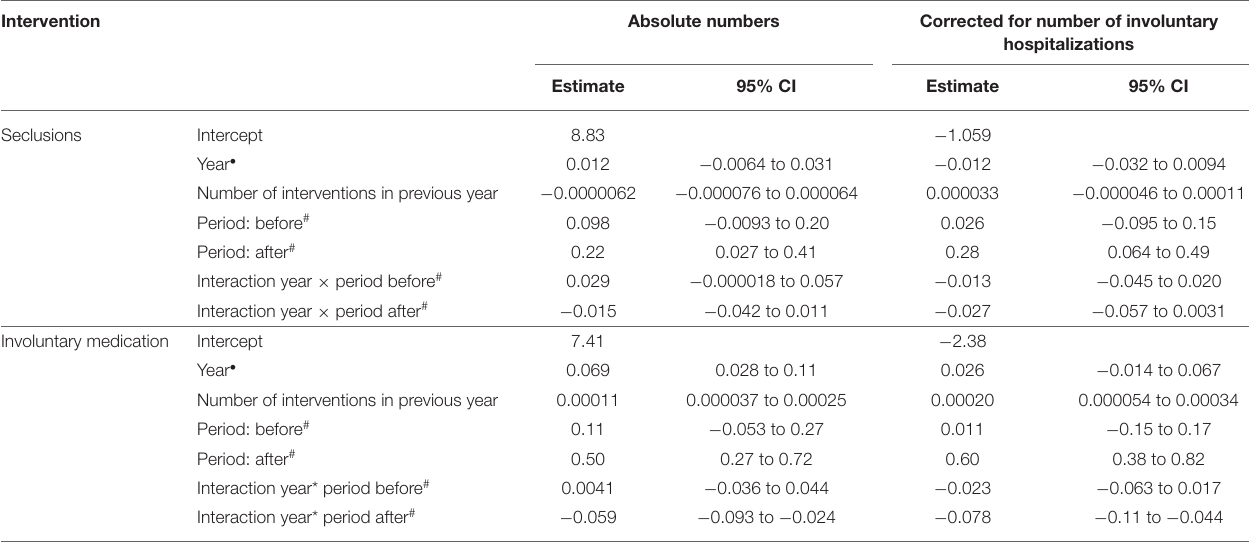
TABLE 1 | Results of quasi Poisson time series models for the registered numbers of seclusion and involuntary medication in the Netherlands, both in absolute numbers and in numbers corrected for the number of involuntary hospitalizations (as used by off-set). Intervention Absolute